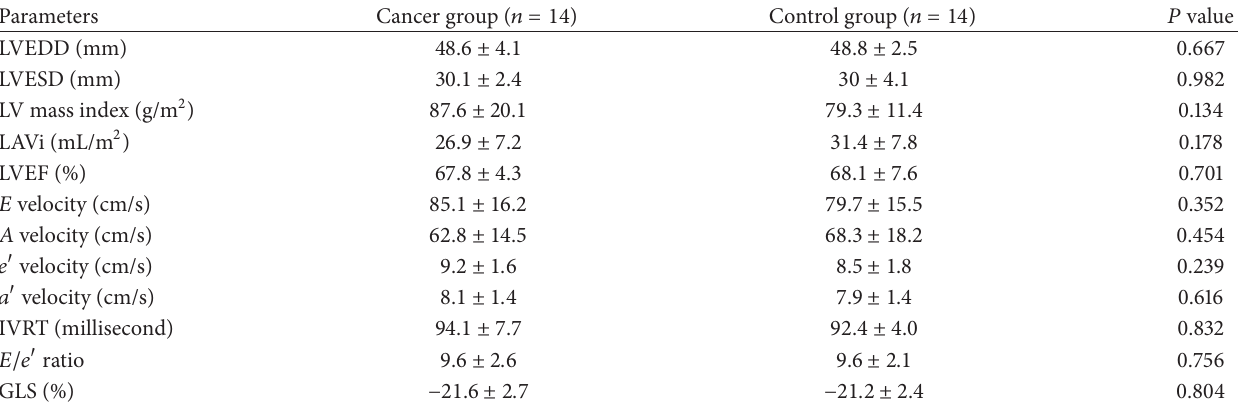
Table 3: Echocardiographic parameters in differentiated thyroid cancer patients and the control